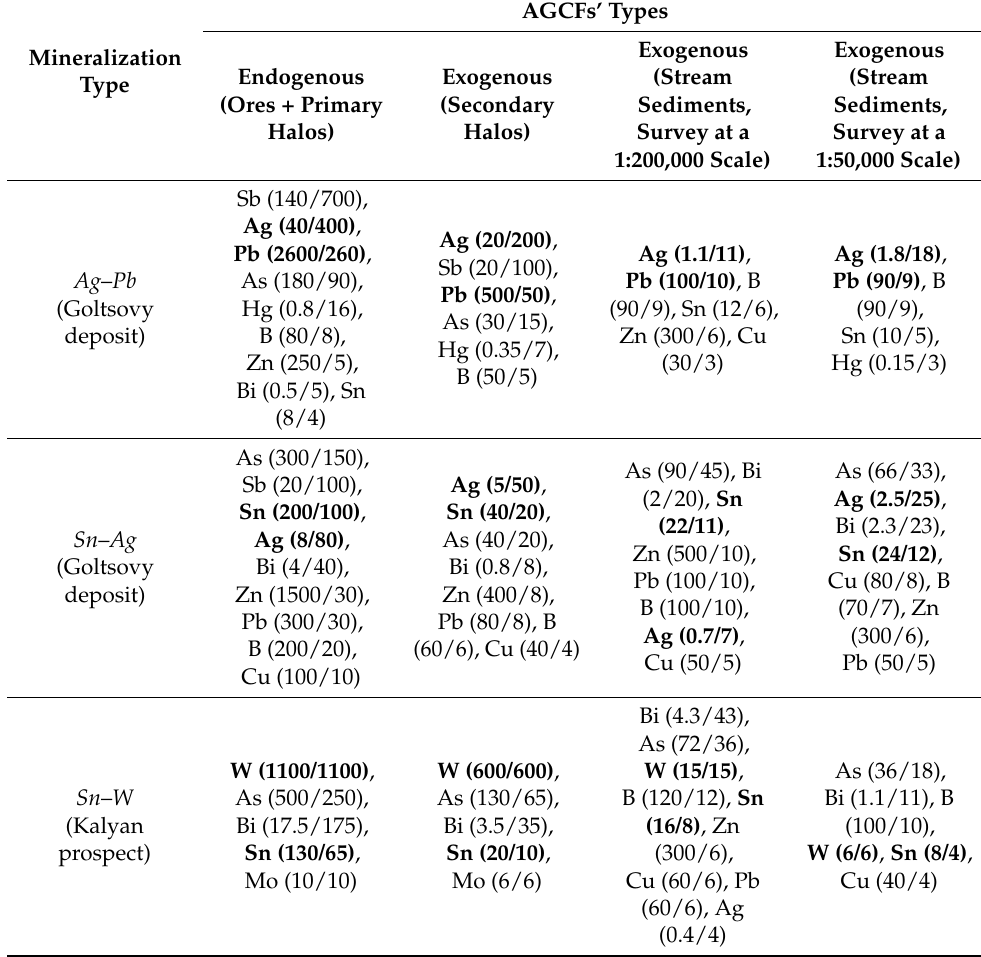
Table 4. Comparative characteristics of qualitative and quantitative relationships in a sequence of endogenous AGCFs → exogenous AGCFs for mineralization of the Pestrinsk SBS. AGCFs’ Mineralization